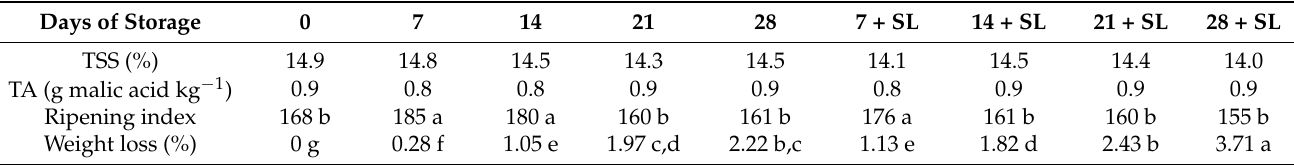
Table 1. Fruit quality parameters (total soluble solids (TSS), total acidity (TA), ripening index and weight loss) calculated in cactus pear fruit during conservation under cold and shelf life (SL) conditions. The values represented are the mean. Days of Storage